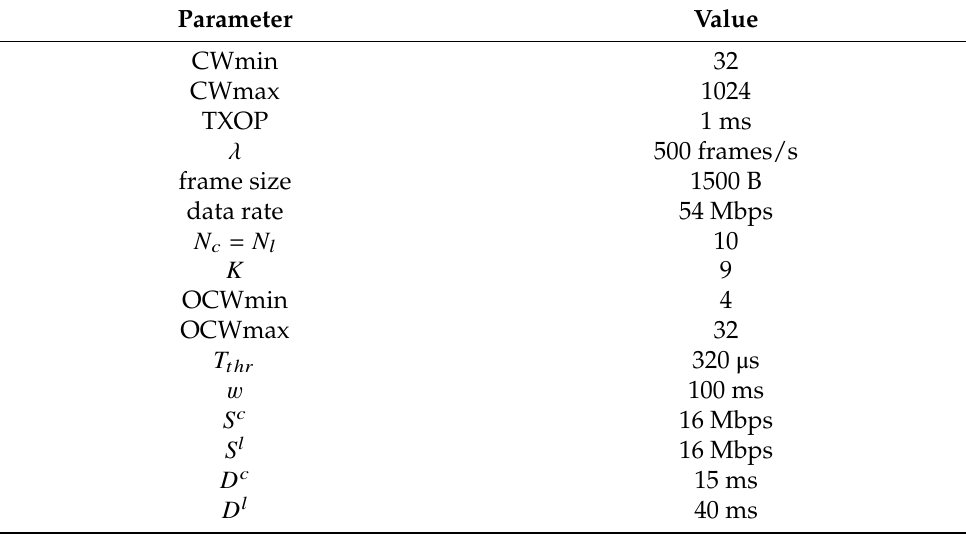
Table 1. Default simulation